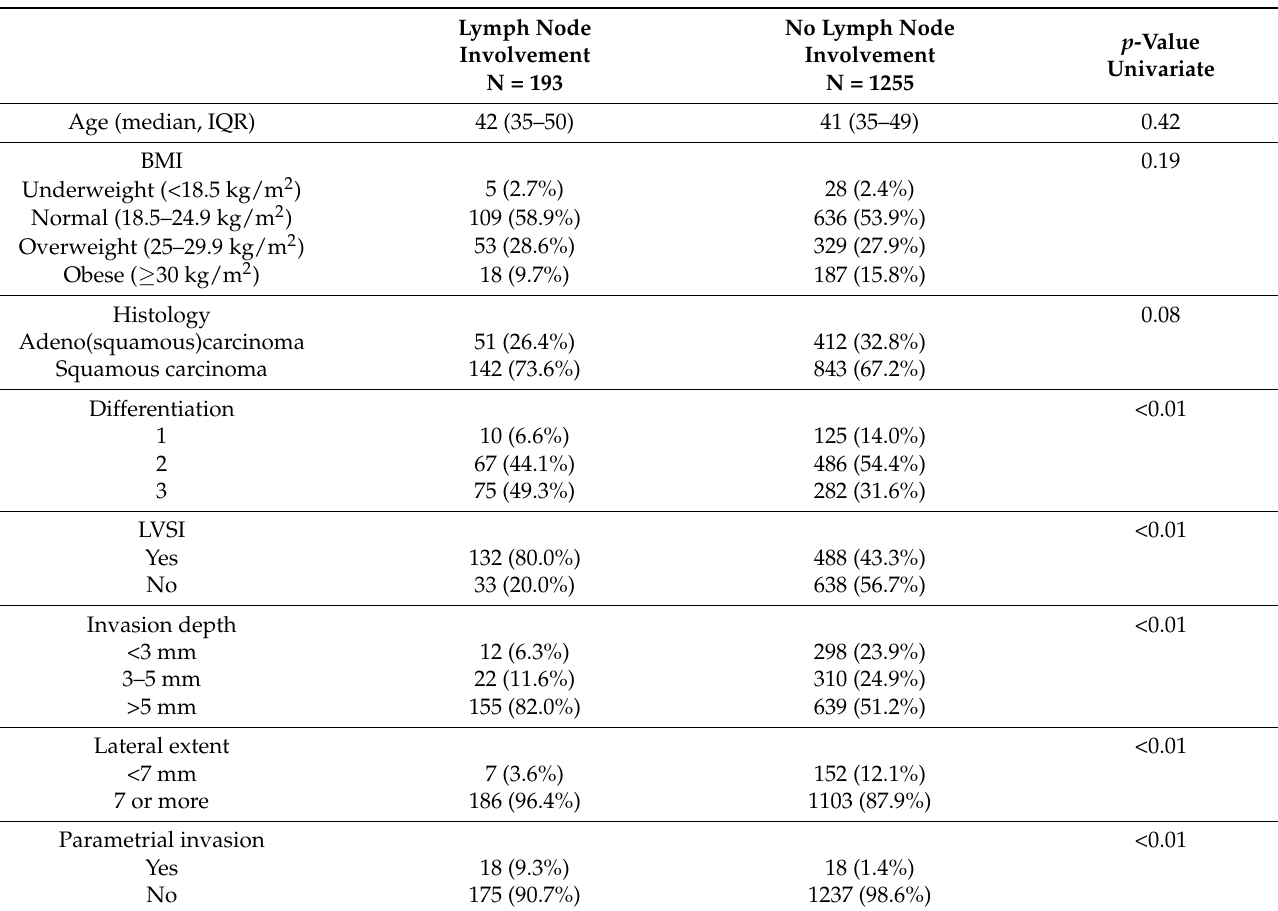
Table 4. Lymph node metastasis and clinical characteristics for all patients who underwent lymph node